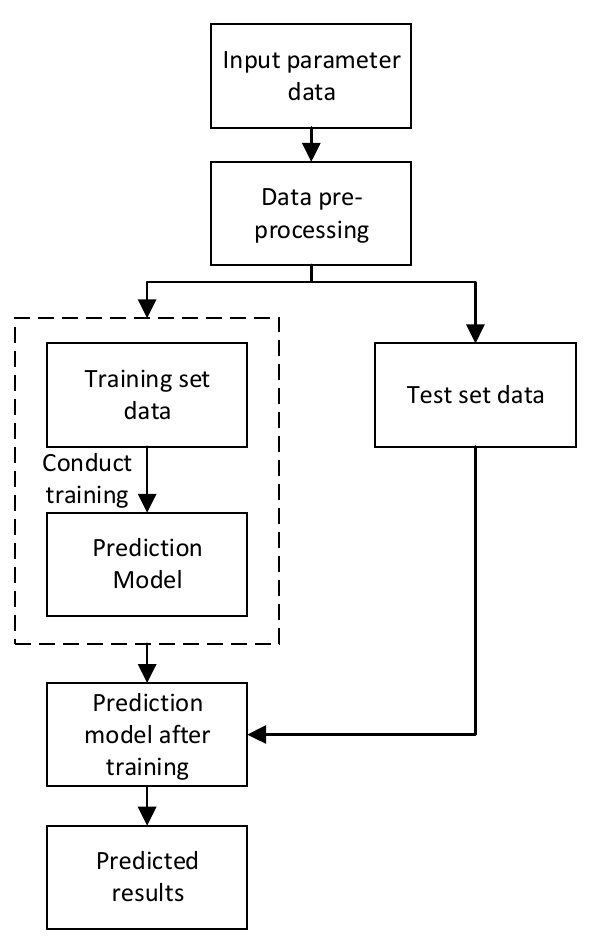
Figure 1. BP Neural Network Design Framework for Genetic Algorithm Optimization.